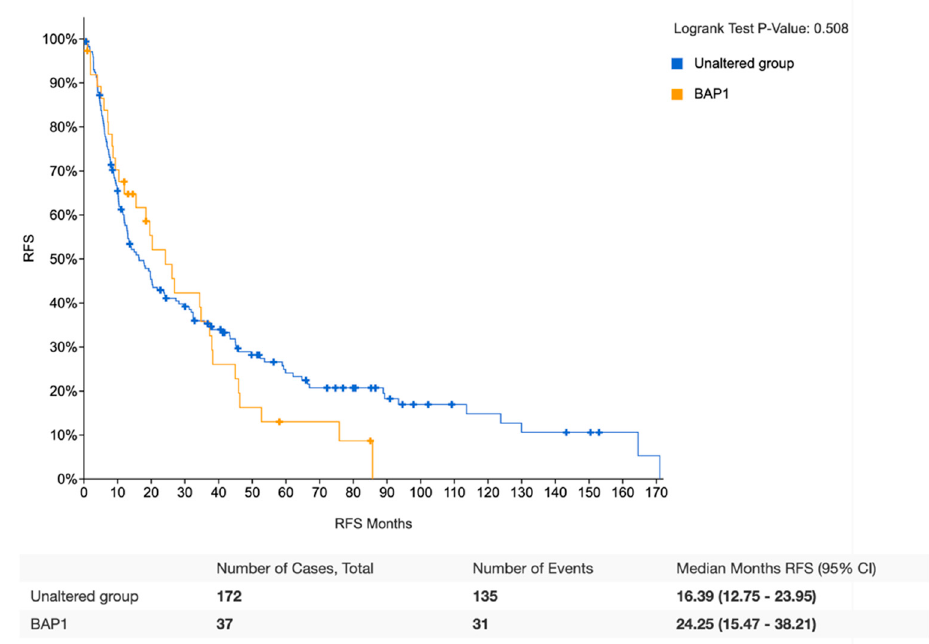
Figure 4. Kaplan–Meier analysis of relapse-free survival of BAP1 -mutant iCCA patients versus BAP1